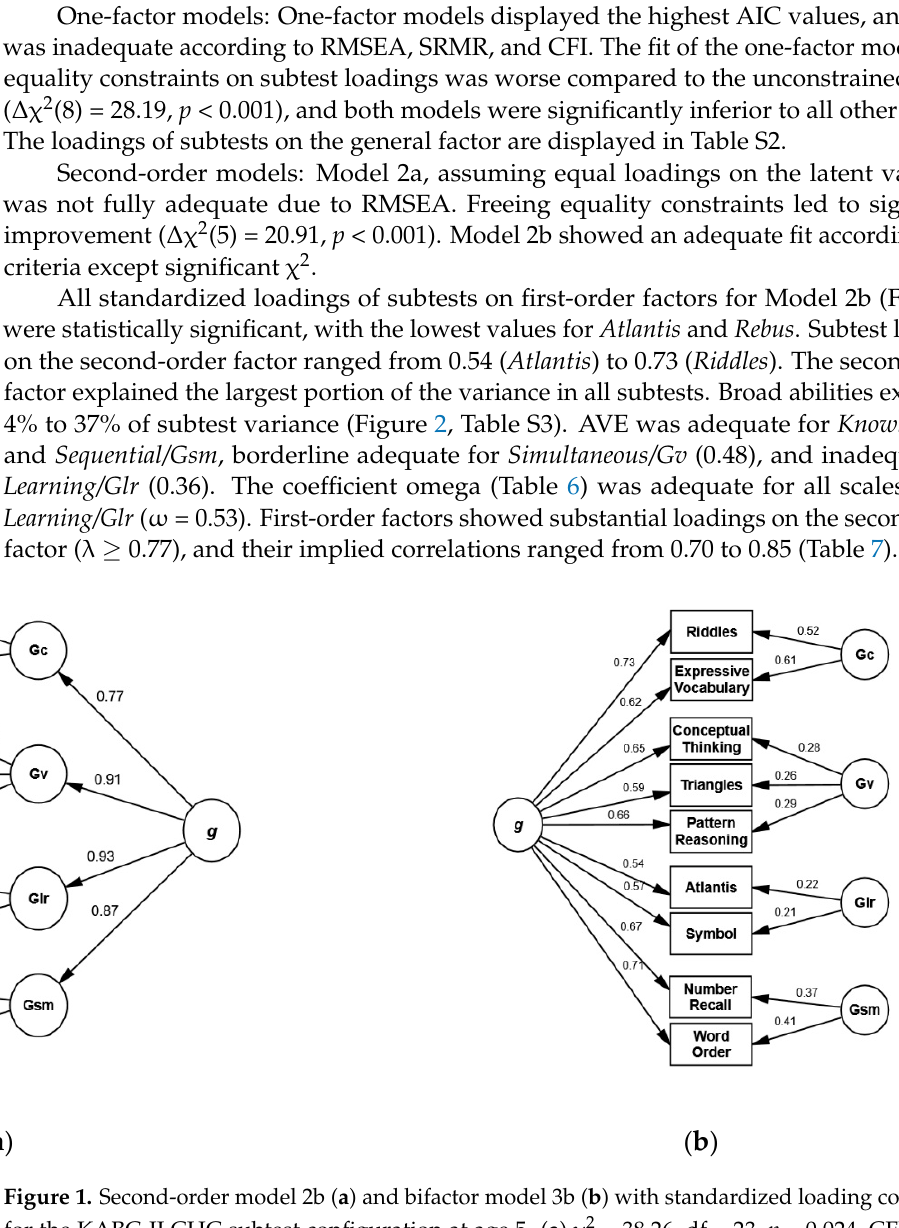
Table 7. Second-order CHC model: Loadings of first-order factors on the general factor and implied correlations of first-order factors for 5- and 6-year-olds.